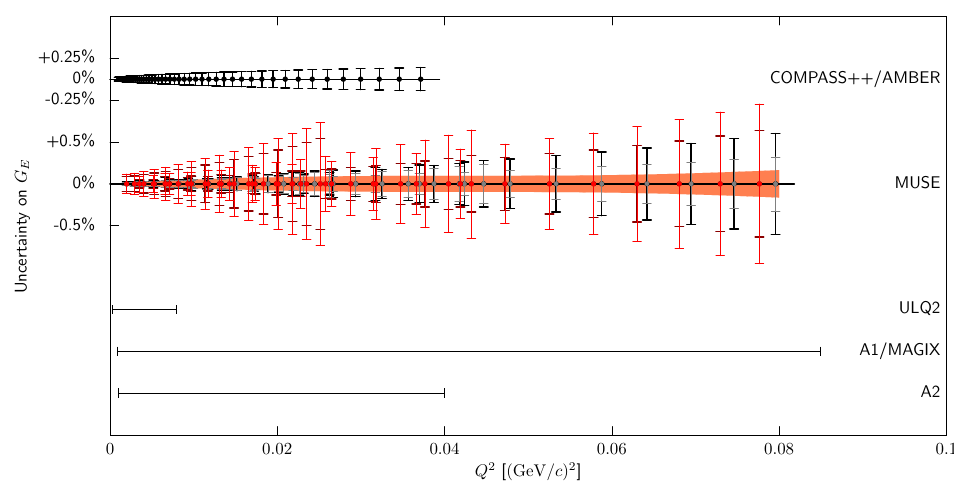
Figure 4. Q 2 ranges and, when available, the expected uncertainties on G E of future planned experiments. COMPASS ++/ AMBER from [53]. MUSE: Projected uncertainty for e + (black), e − (grey), µ + (dark red) and µ − (bright red), from [51]. The fit uncertainty (orange) has been determined by the